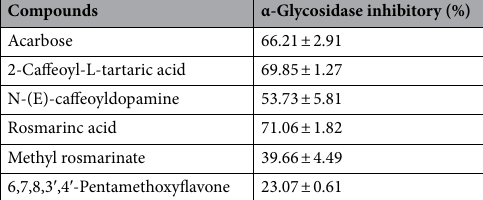
Table 2. α-Glycosidase inhibitory activity of five compounds.